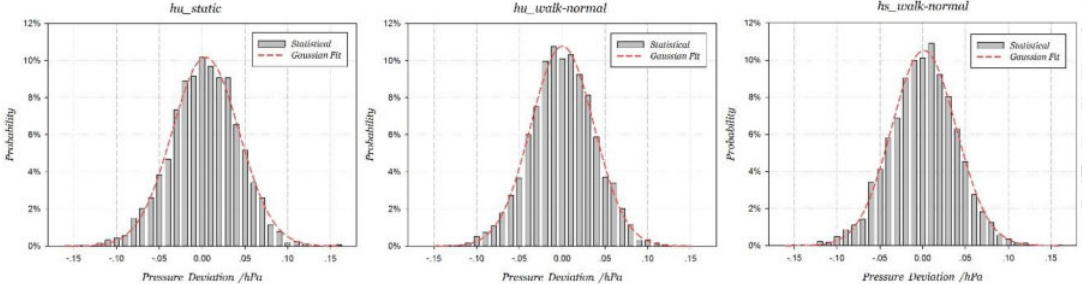
Figure 9. Gaussian fitted curves of pressure signals in three